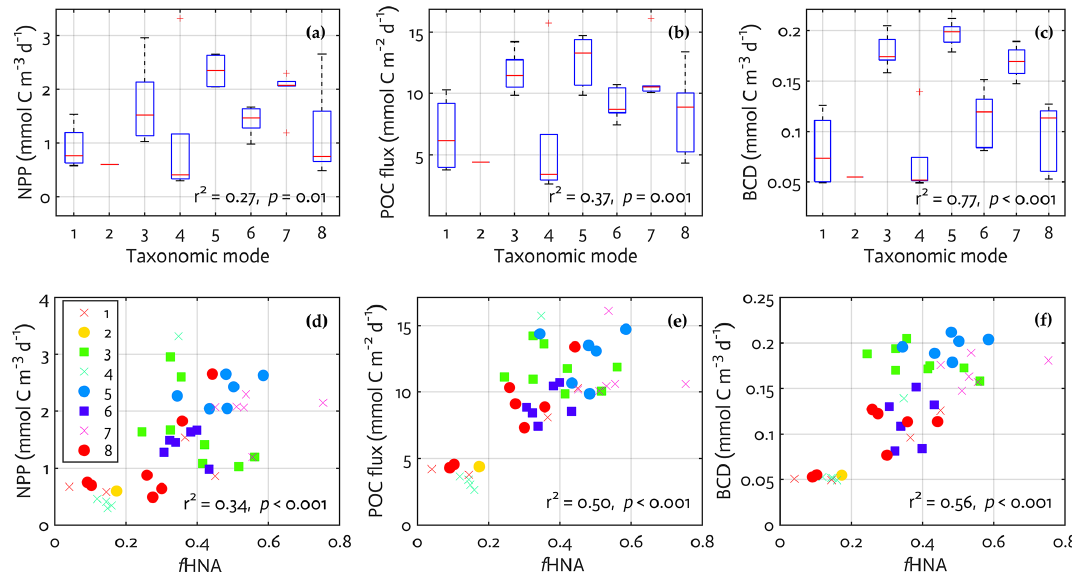
Figure 6. Bacterial physiological and taxonomic association with modeled ecosystem functions. The results from linear regression of the key modeled ecosystem functions on a categorical predictor of the observed mode (a–c) and on the observed fraction of HNA cells (d–f) . Regression statistics: (a) number of observations (N) = 43, error degrees of freedom (df ) = 35, root-mean-square error (RMSE) = 0.68, r 2 = 0.39, adjusted r 2 = 0.27, F statistic value = 3.22, p value = 0.01; (b) N = 43, df = 35, RMSE = 2.88, r 2 = 0.48, adjusted r 2 = 0.37, F statistic value = 4.55, p value = 0.001; (c) N = 43, df = 35, RMSE = 0.03, r 2 = 0.81, adjusted r 2 = 0.77, F statistic value = 20.7, p value < 0.001; (d) N = 43, df = 41, RMSE = 0.65, r 2 = 0.36, adjusted r 2 = 0.34, F statistic value = 22.8, p value < 0.001; (e) N = 43, df = 41, RMSE = 2.57, r 2 = 0.51, adjusted r 2 = 0.50, F statistic value = 43.0, p value < 0.001; (f) N = 43, df = 41, RMSE = 0.04, r 2 = 0.57, adjusted r 2 = 0.56, F statistic value = 53.5, p value <